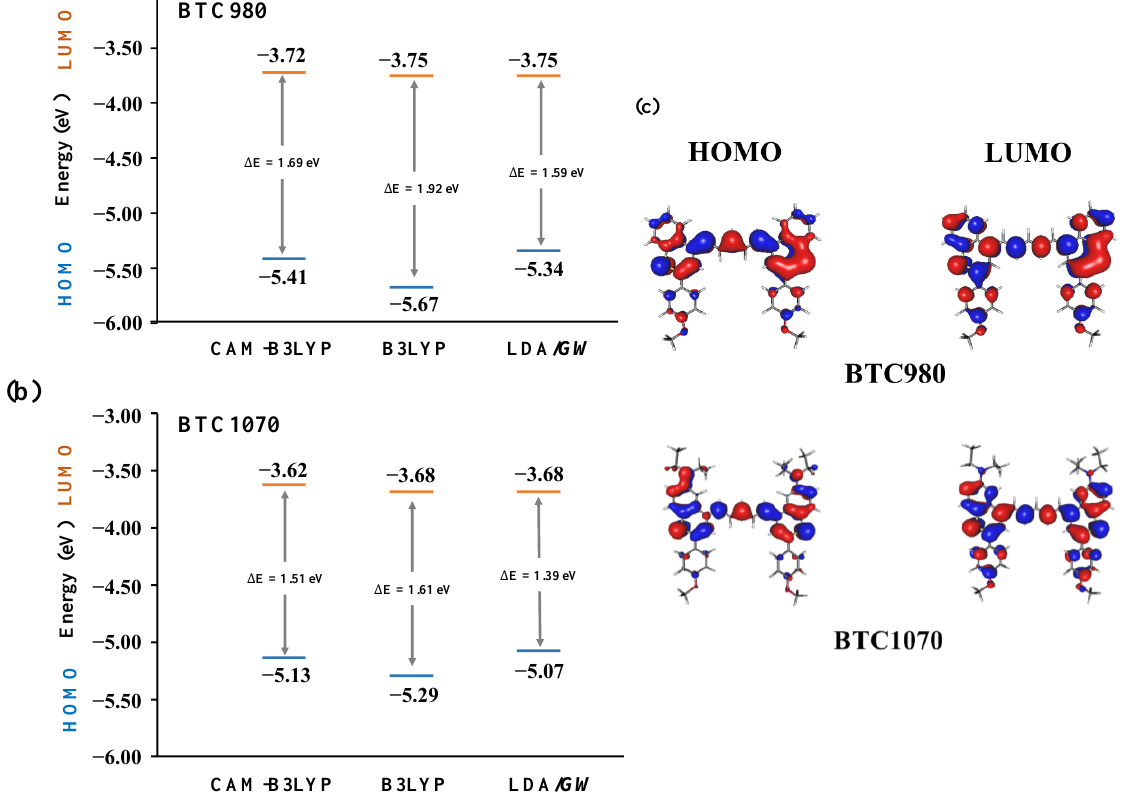
Figure 4. The HOMO and LUMO energy levels, and HOMO-LUMO gaps in ( a ) BTC980 and ( b ) BTC1070, as estimated using LDA/ GW , B3LYP, and CAM-B3LYP calculations. ( c ) The HOMO, LUMO orbital distribution in BTC980 and BTC1070. The LUMO levels are shown in green, whereas the HOMO levels are shown in red.